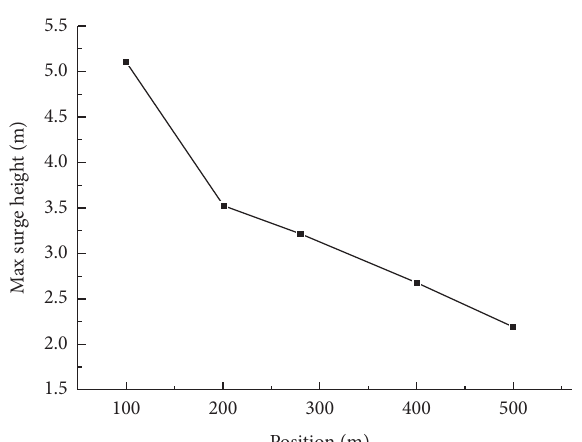
Figure 12: Maximum wave height of surges at different locations.